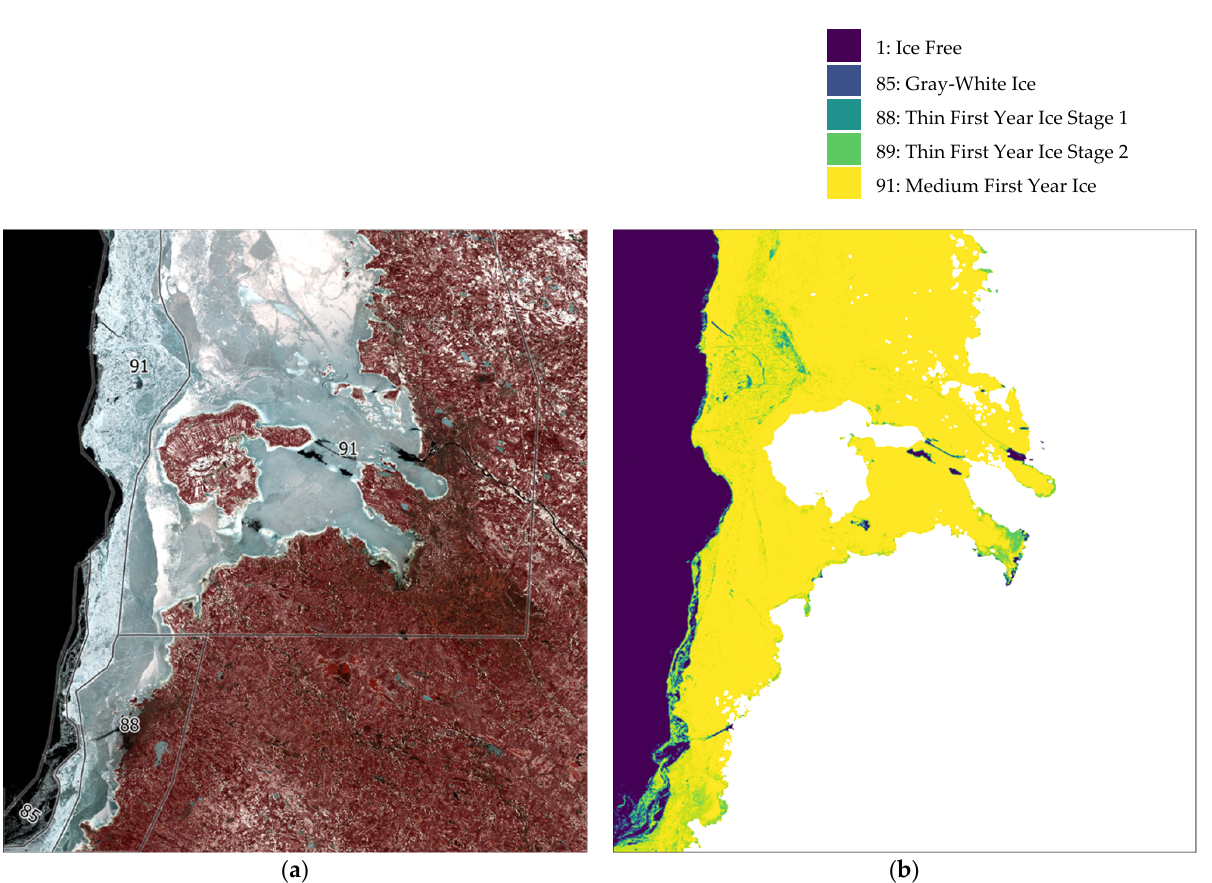
Figure 14. ( a ) Landsat-8 false color for 16 April 2019; BSH ice chart for 15 April 2019; ( b ) ICESOD classification.